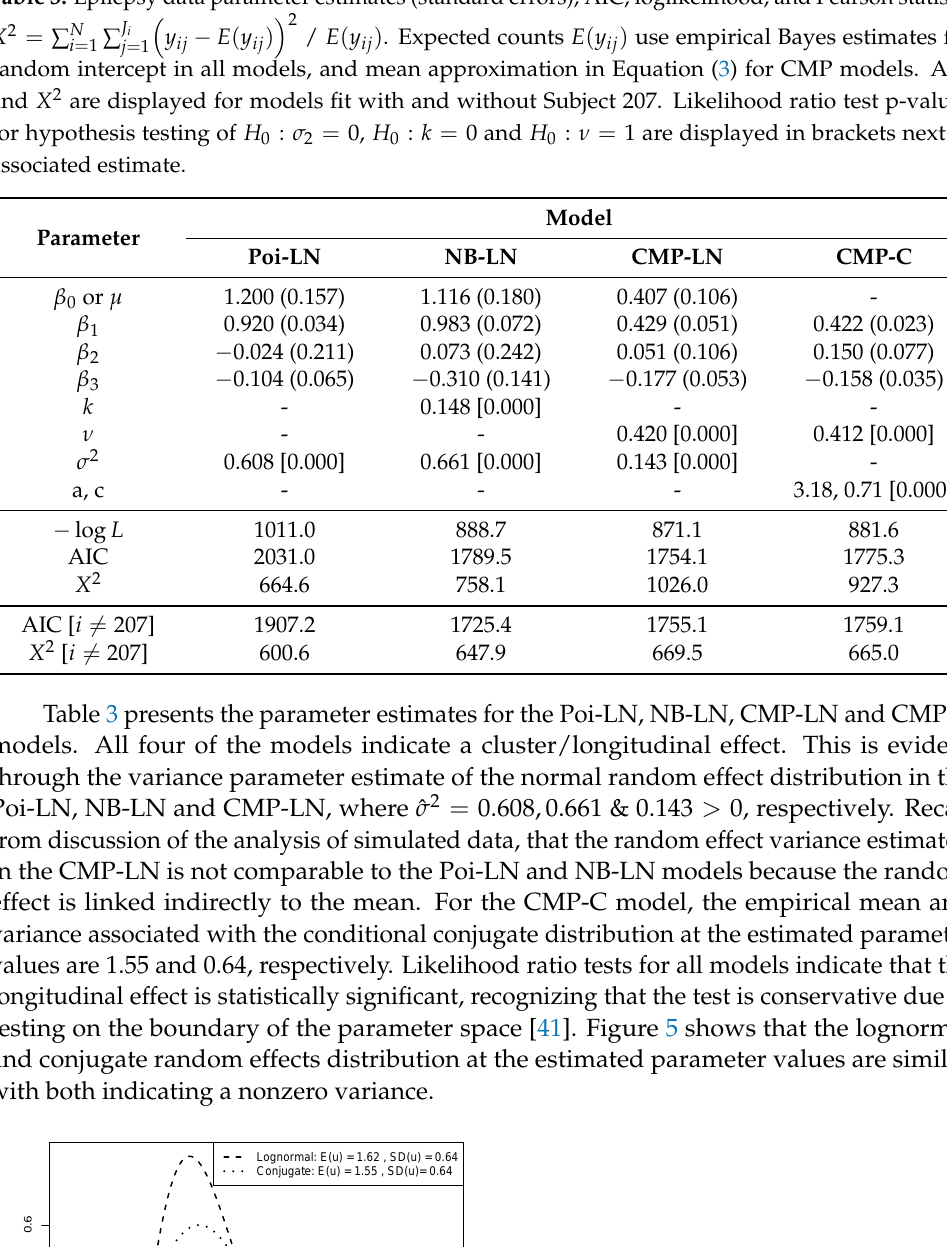
Table 3. Epilepsy data parameter estimates (standard errors), AIC, loglikelihood, and Pearson statistic